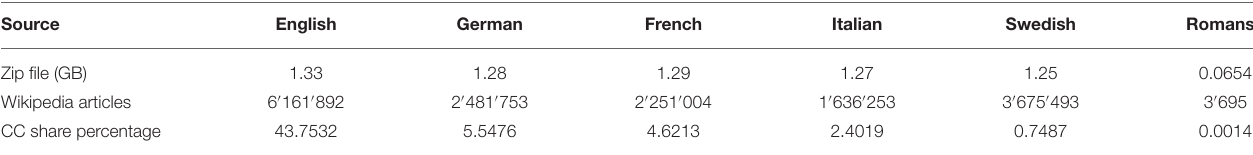
TABLE 1 | Size comparison of the different fastText word embeddings used in this paper. Source